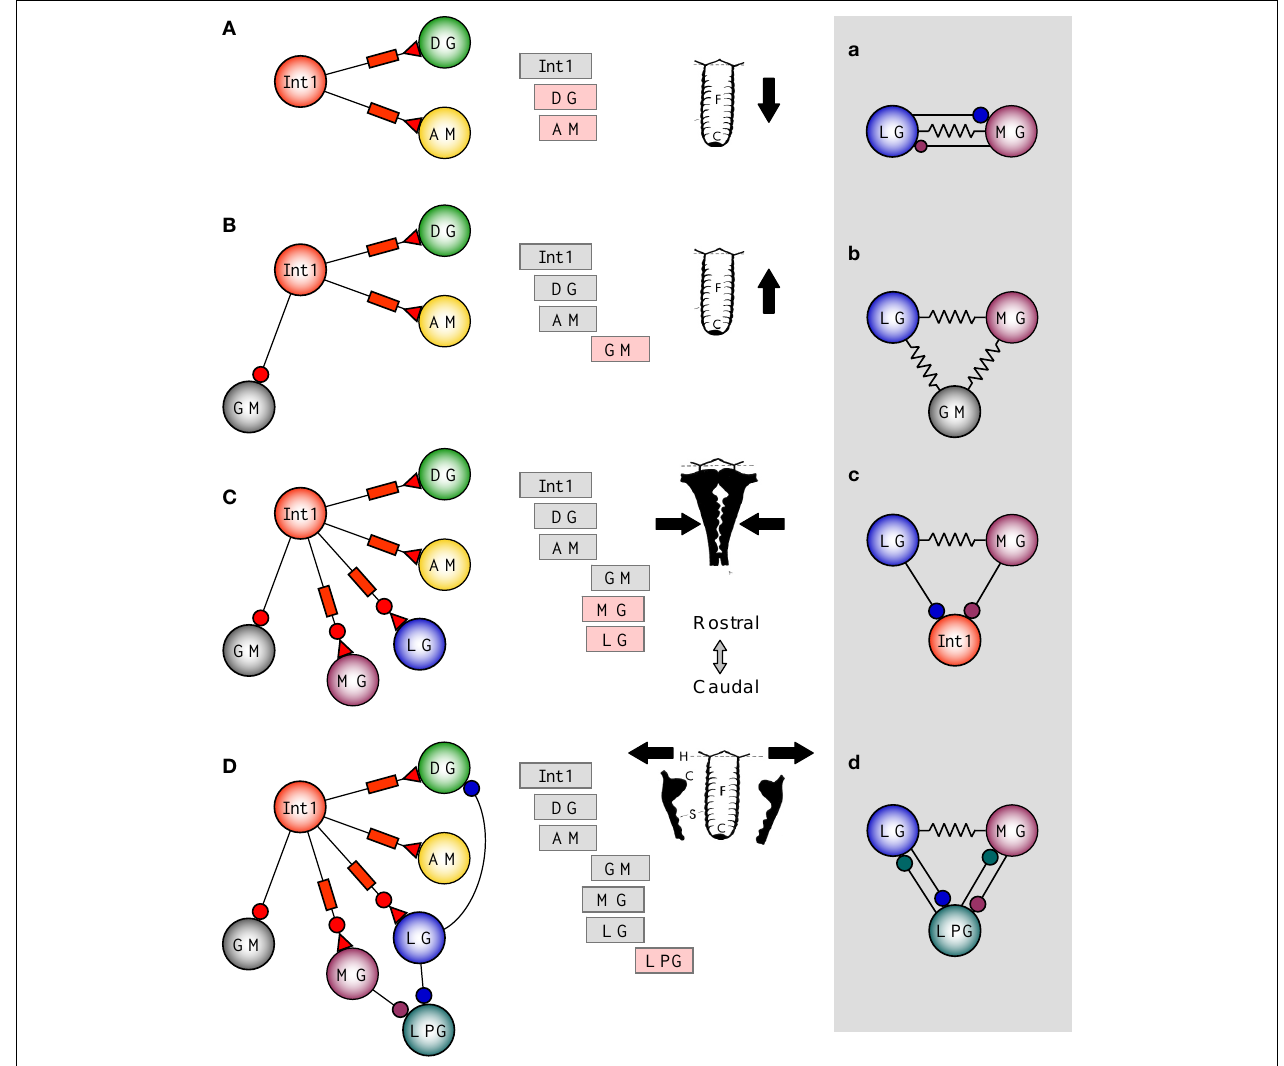
FIGURE 14 | Summary of synchronization of lateral and medial teeth circuits by Interneuron 1. Arbitrarily starting with an Int 1 burst exciting DG and AM, three phases of activity are set up (A) . The DG and AM are motor neurons that reset the medial tooth are directly excited by Int 1. At the same time Int 1 also inhibits GM (B) so that it fi res out-of-phase with the DG/AM pair and moves